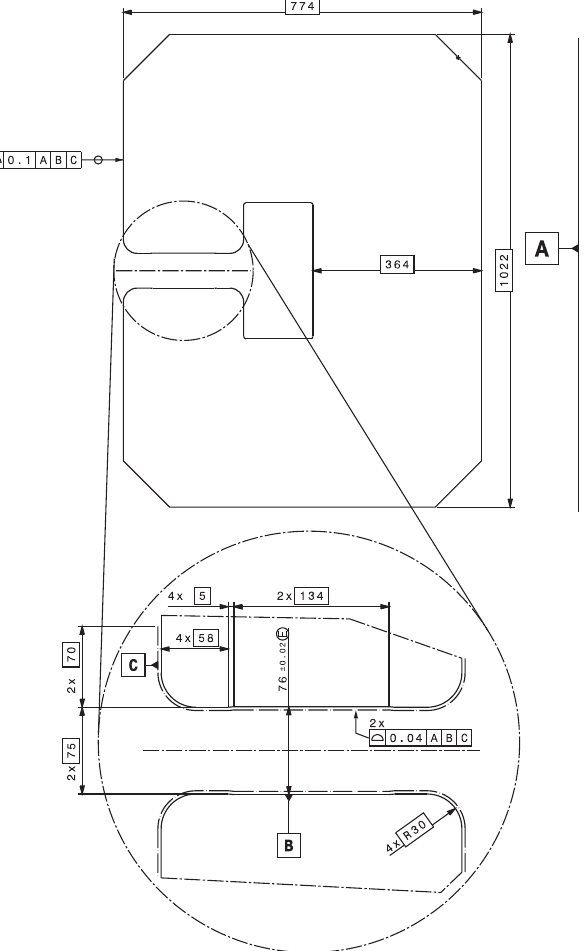
FIG. 5. Cross section and pole profile of ELENA dipole magnet.